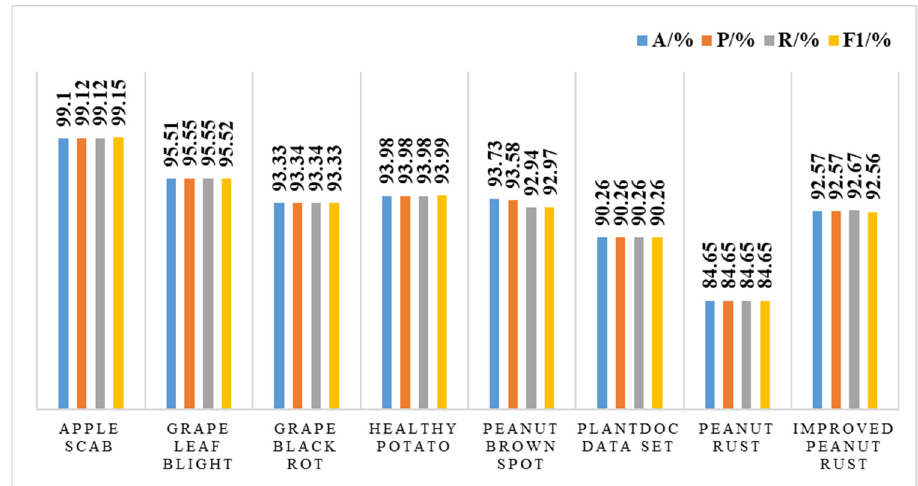
Figure 16. Detection results of different datasets (apple scab, grape leaf blight, grape black rot, healthy potato, peanut brown spot, PlantDoc dataset, peanut rust, and improved peanut rust).